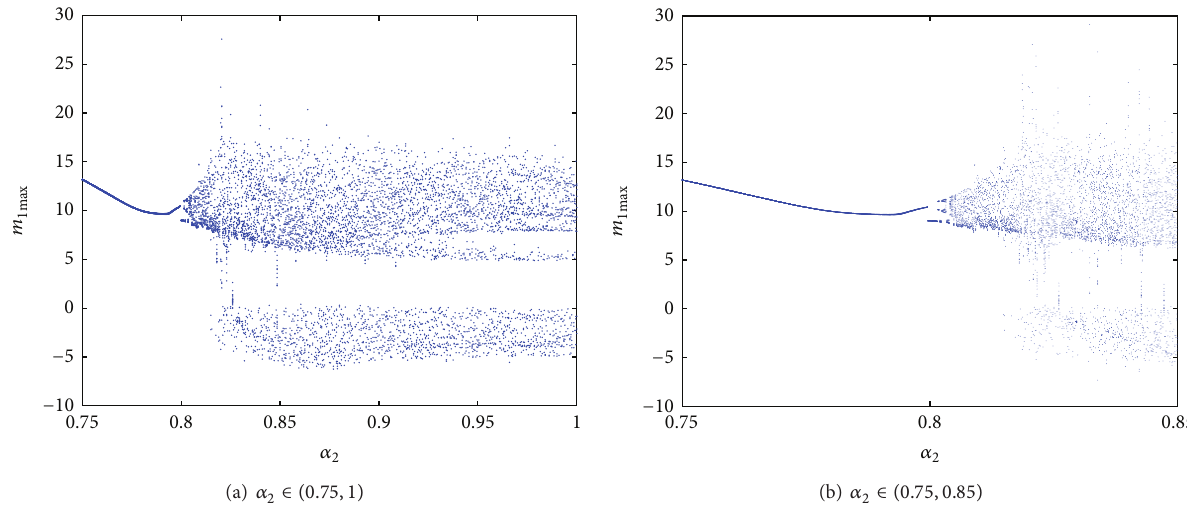
Figure 7: Bifurcation diagram of system (5) at 𝛼 1 = 𝛼 3 = 1 with 𝛼 2 varying.